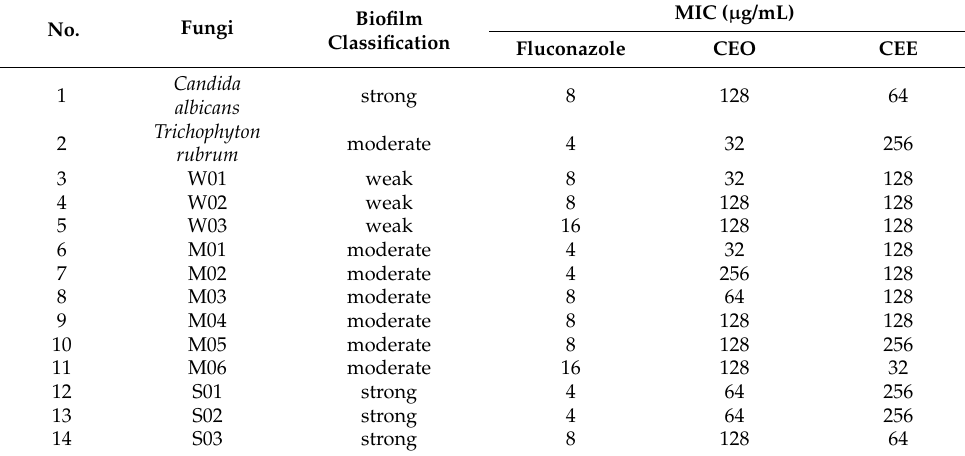
Table 3. Biofilm classification and minimum inhibitory concentration (MIC) of CEO, CEE, and fluconazole against planktonic cells of fungal isolates .